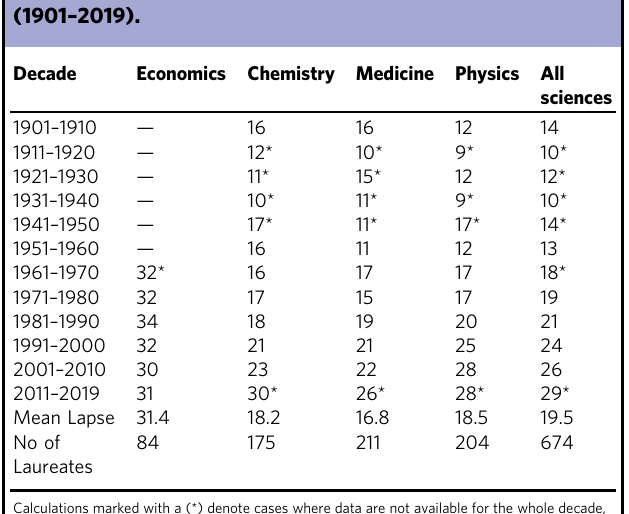
Table 1 Nobel Prize laureates grouped according to the number of years elapsed between the publication of their most prominent work and the time they received the Nobel Prize, by discipline (1901 –